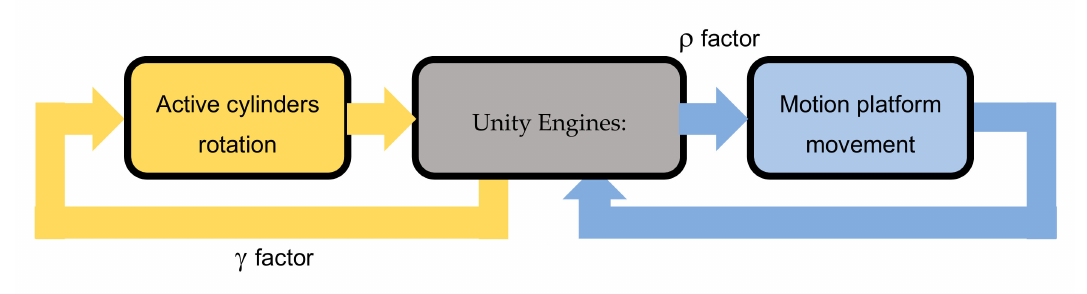
Figure 7. Scheme of the bidirectional communication between the elements of the motion physical systems and Unity engines.